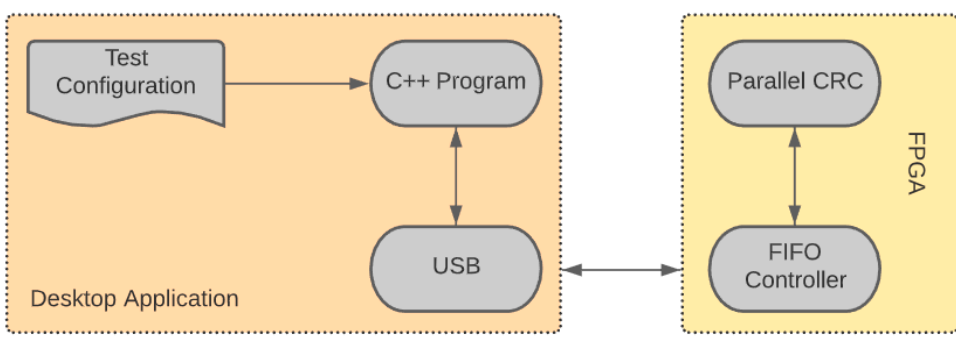
Figure 11. Simplified diagram of the test system.